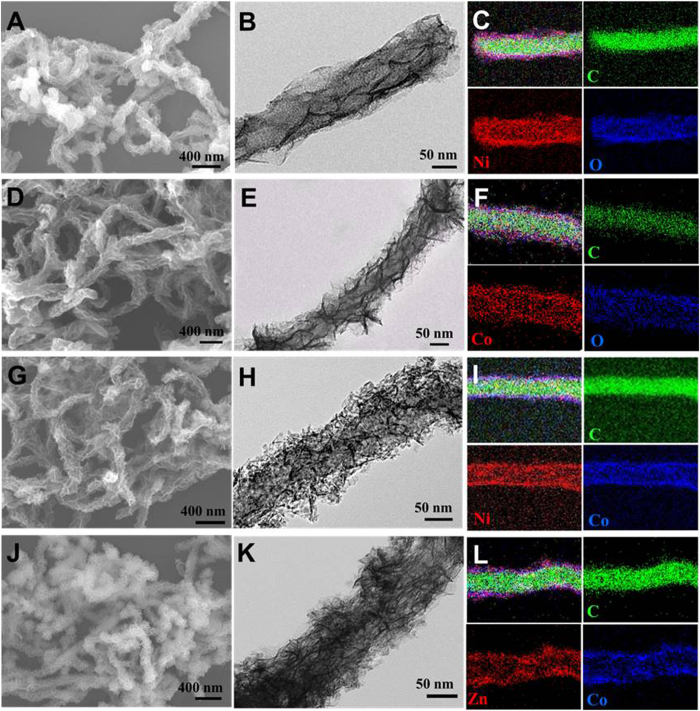
SEM, TEM and EDS mapping images of (A,B and C) NiO@CNT, (D,E and F) Co3O4@CNT, (G,H and I) NiCoO2@CNT and (J,K and L) ZnCo2O4@CNT.